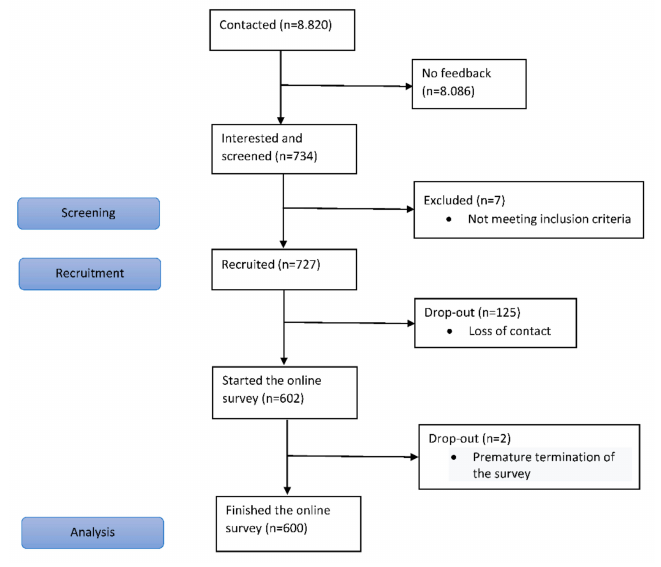
Figure 1. Flow chart of the study. Table 1. Demographic and professional characteristics of the physicians